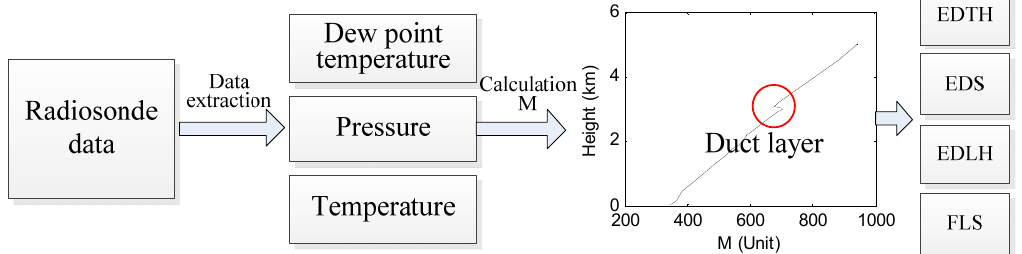
Figure 5. Flow chart for calculating duct parameters.